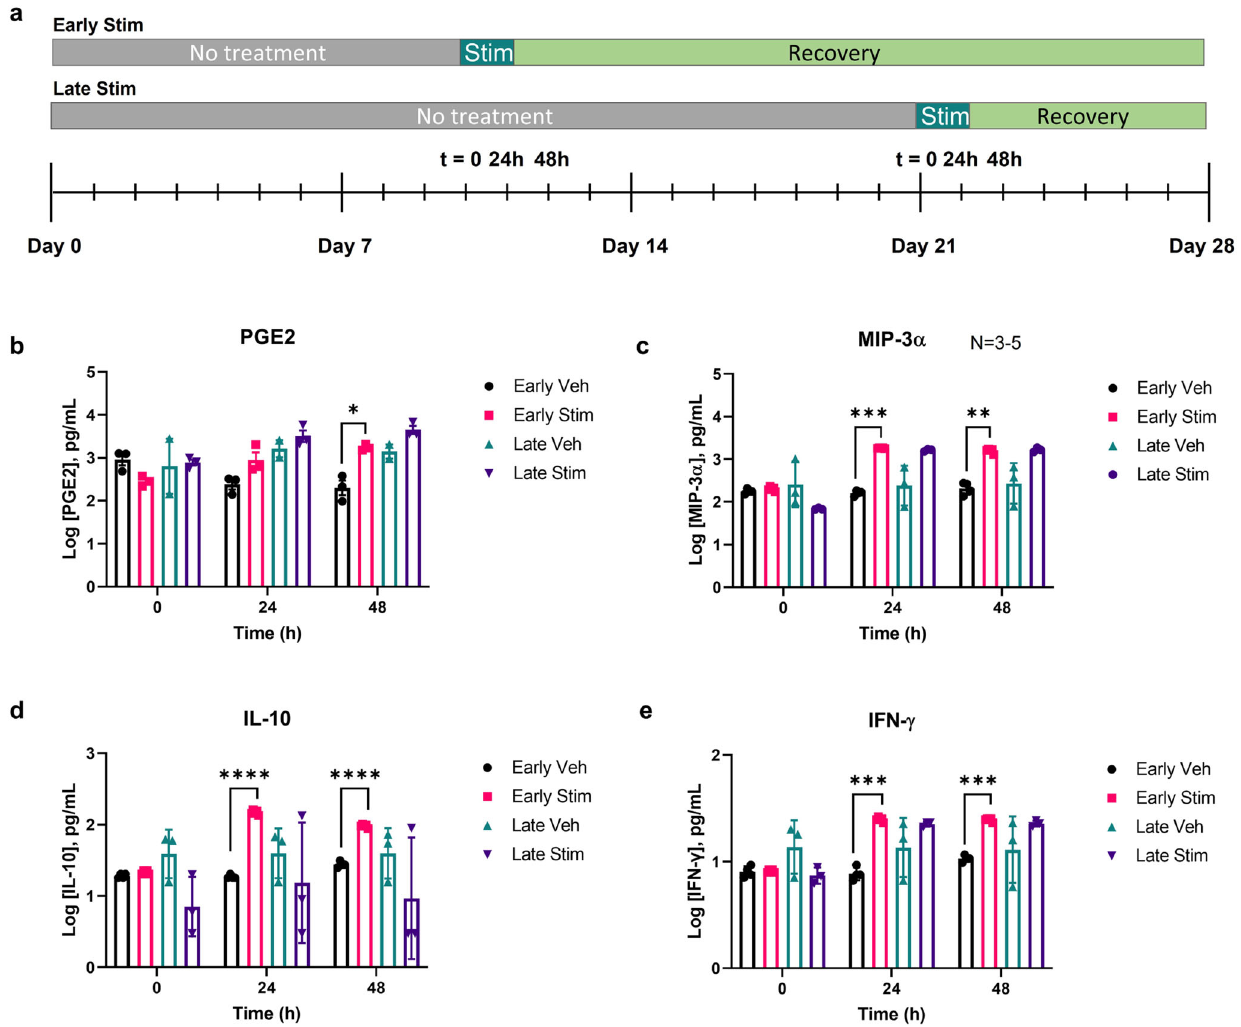
Fig. 3 MOUTH tissue responded to in fl ammatory stimuli at different time points over the 20-day testing window. a An early and late stimulation were applied to MOUTH devices at 10 and 21 days, respectively, and evaluated compared to vehicle controls. b Similar trends of secreted levels of PGE2 were observed between Early and Late Stim conditions compared to corresponding vehicles, but only Early Stim was signi fi cant by 48 h compared to controls. Data represent at least three replicates from one experiment. c – e MOUTH tissue has a similar in fl ammatory response to stimulation during the testing window. Devices stimulated with in fl ammatory cytokines TNF- α + IL-1 β presented signi fi cant increases in MIP-3 α , IL-10, and IFN- γ at 24 h under Early Stim conditions, and trended similarly in MIP-3 α and IFN- γ secretion under Late Stim conditions. In all cases, error bars represent standard deviation. Signi fi cance was determined by Tukey ’ s test for b , and Dunnett ’ s T3 multiple comparisons test for c – e . Signi fi cance: * p < 0.0332, ** p <